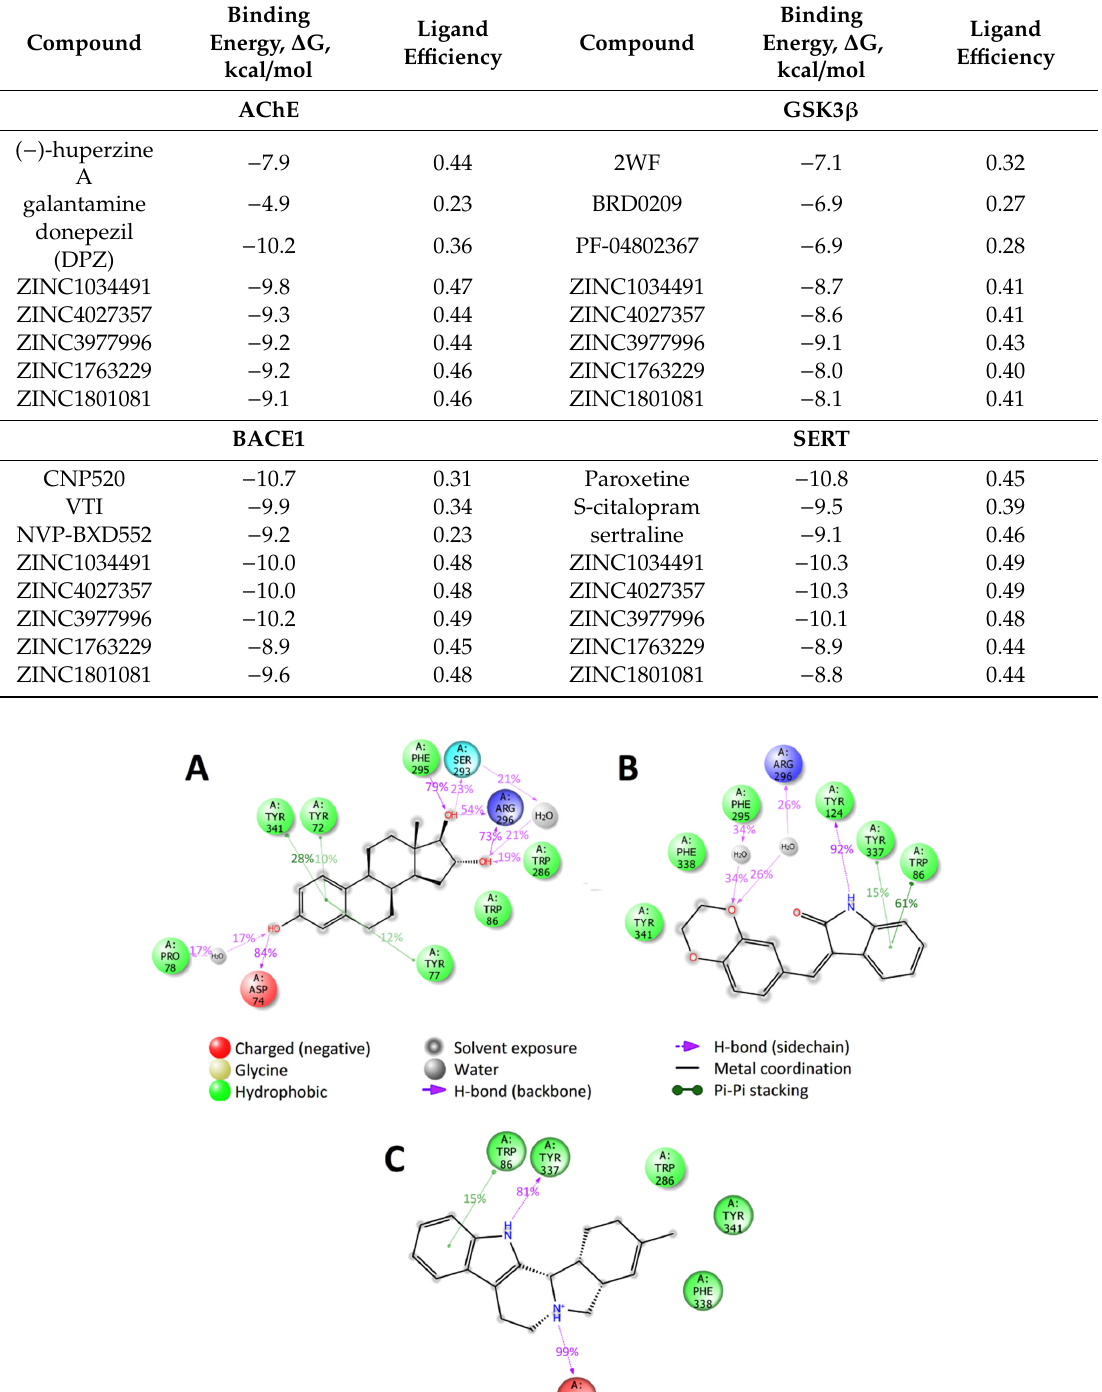
Table 3. Calculated binding energies (kcal / mol) and binding modes of selected small-molecule ligands and known inhibitors to target proteins (AChE, BACE1, GSK3 β and SERT).